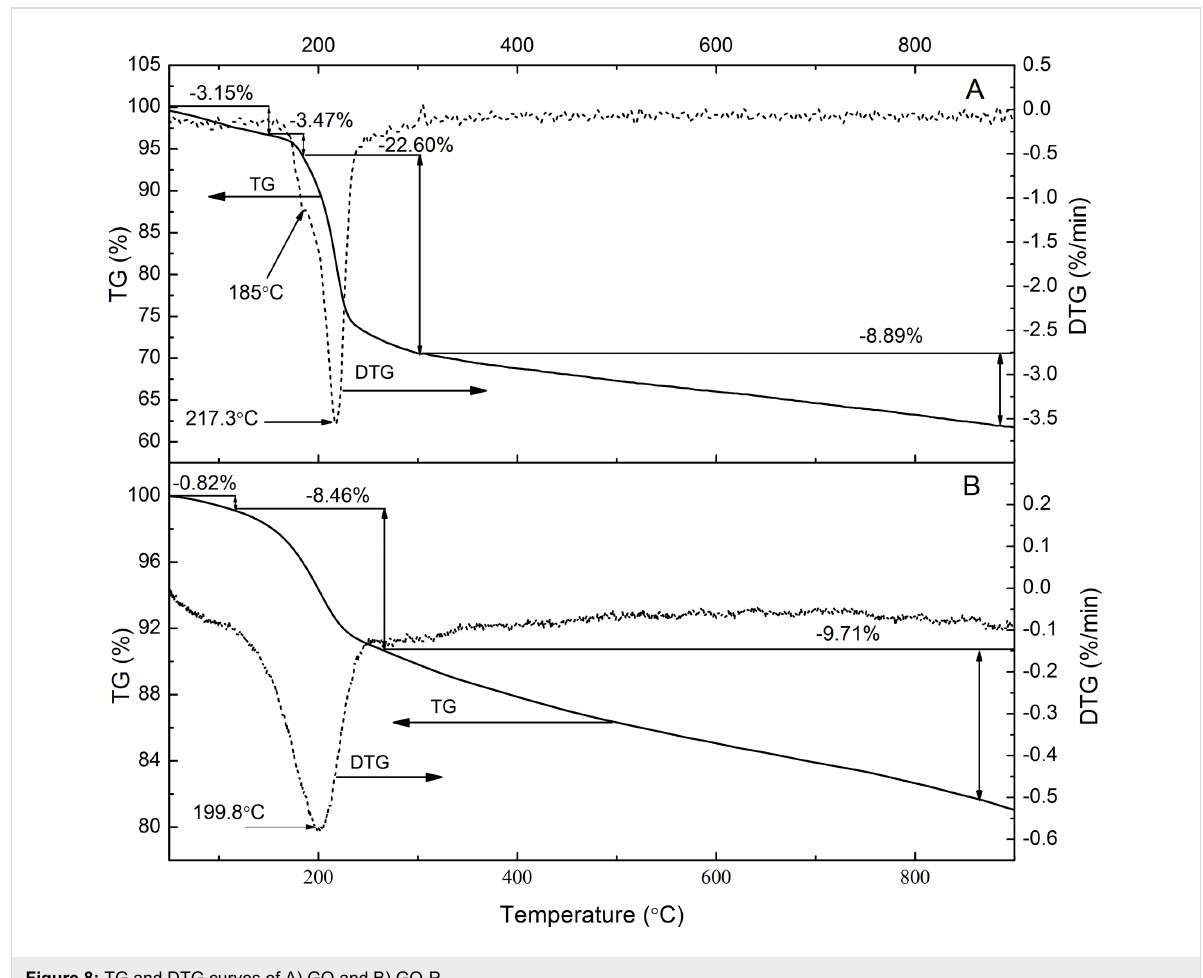
Figure 8: TG and DTG curves of A) GO and B)